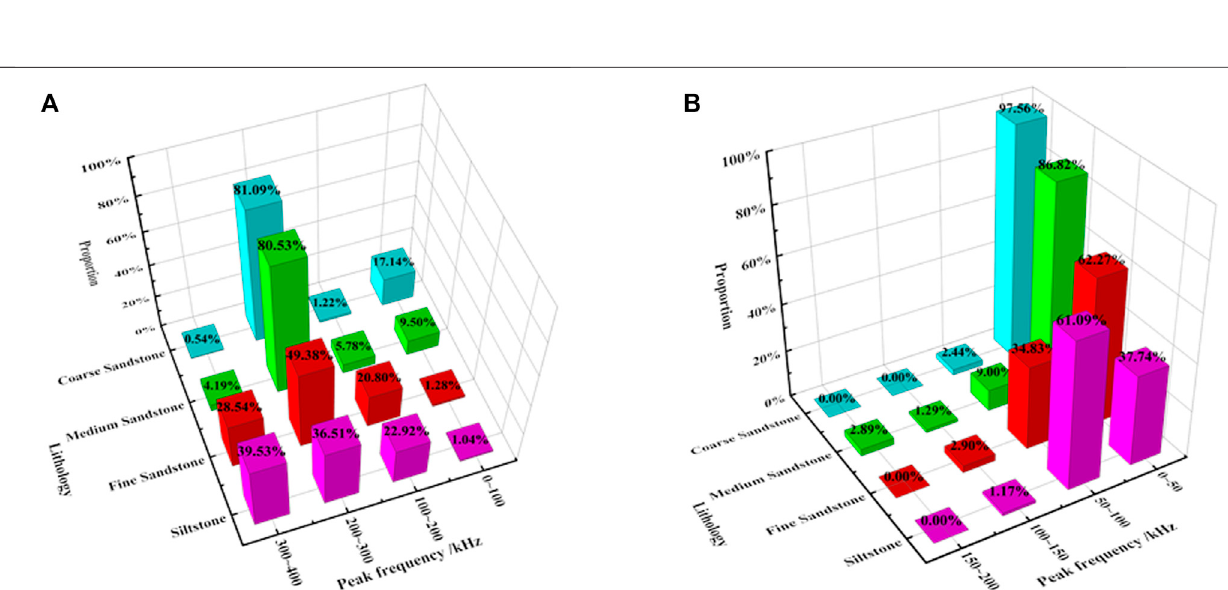
Frontiers in Earth Science |